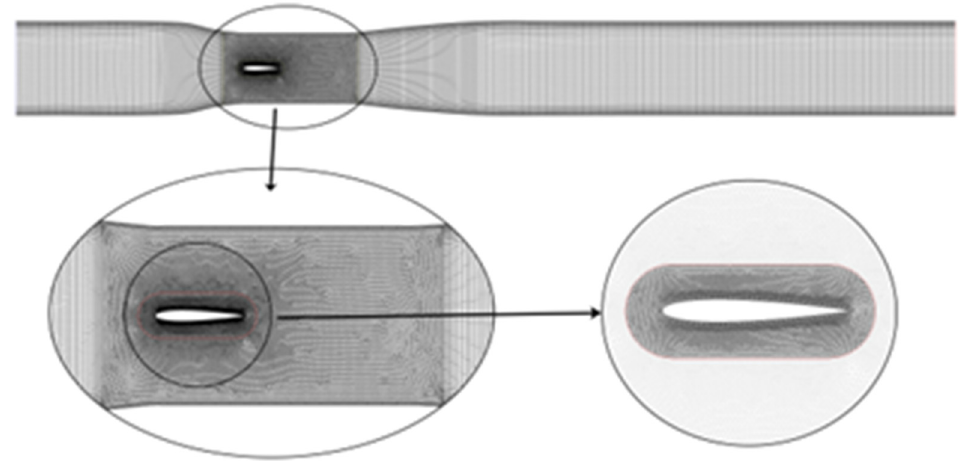
Figure 6. Computational domain and grid partition.